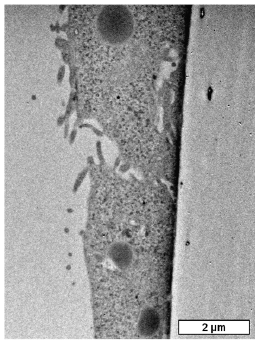
Figure 4. TEM micrograph of a D407 cell, after exposure to PEM microcapsules, showing three internalized microcapsules.